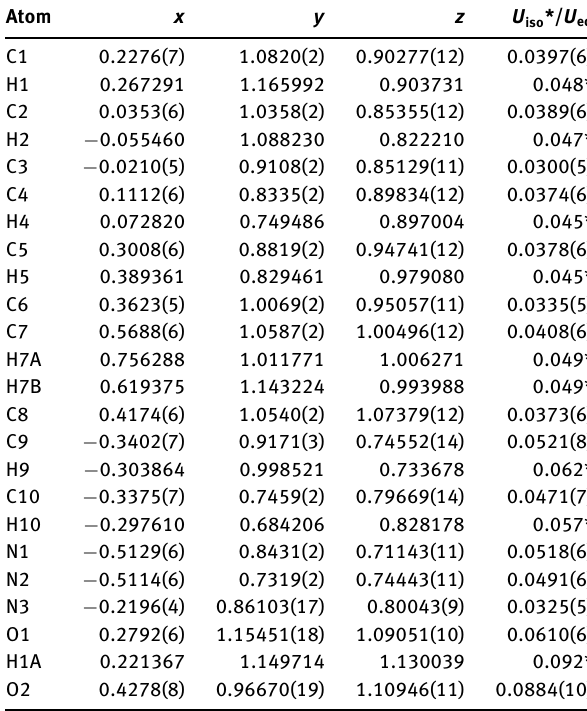
Table 2: Fractional atomic coordinates and isotropic or equivalent isotropic displacement parameters (Å 2